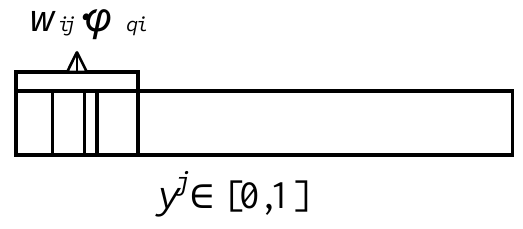
Figure 4. Sample data activation.